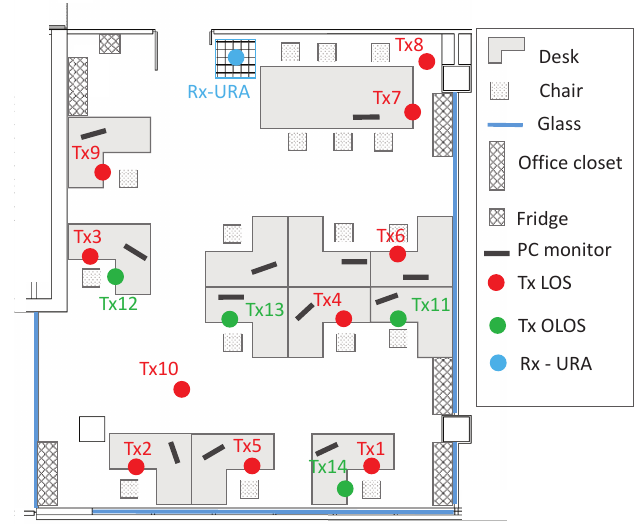
Figure 4. Top view of the propagation environment. The Rx-URA and the Tx antenna locations are indicated.